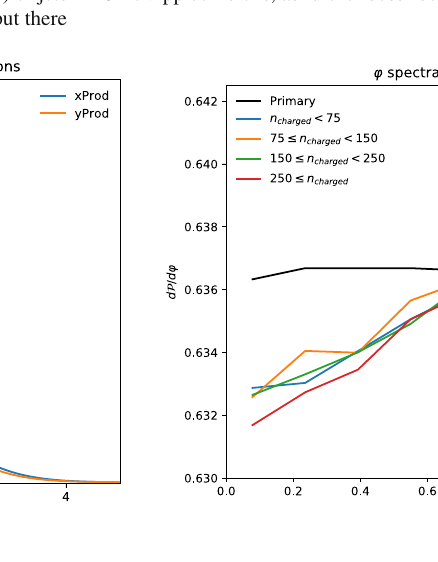
to the event plane, ϕ ∈ [ 0 ,π/ 2 ] . The plot includes the spectrum for the primary hadrons, which illustrates that there is no flow before a collective behaviour has been induced by